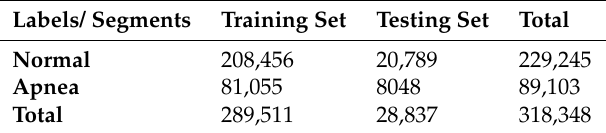
Table 2. Segments for training and testing classification